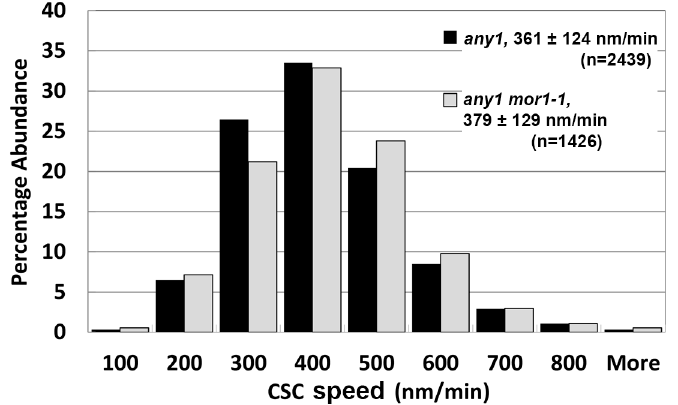
Figure 4. The mor1-1 mutation increases CSC speed through a mechanism that is independent of the CSC catalytic activity. CSC speed distribution in any1 single mutant and the any1mor1-1 double mutant at 29 °C.